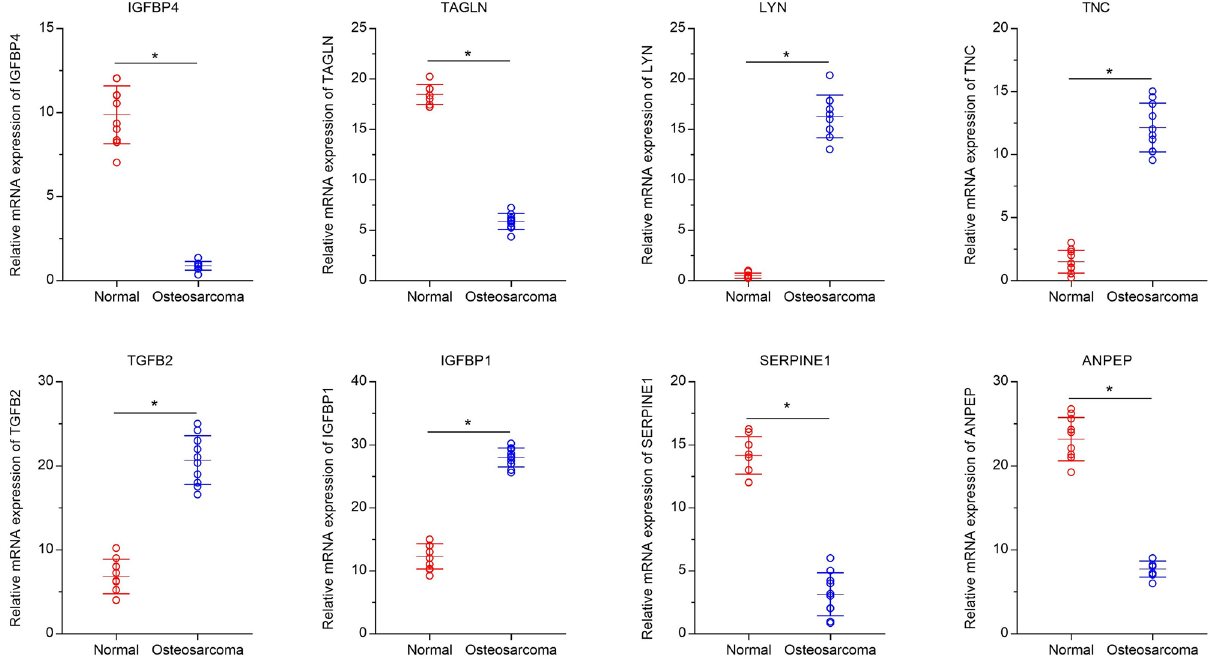
Figure 9. RT-qPCR for hub genes. The relative expression levels of IGFBP4, SERPINE1, ANPEP and TAGLN were significantly lower in the osteosarcoma group compared with the normal group. However, the relative expression levels of LYN, TNC, TGFB2, and IGFBP1 were significantly higher in the osteosarcoma group compared with the normal group. (*P <